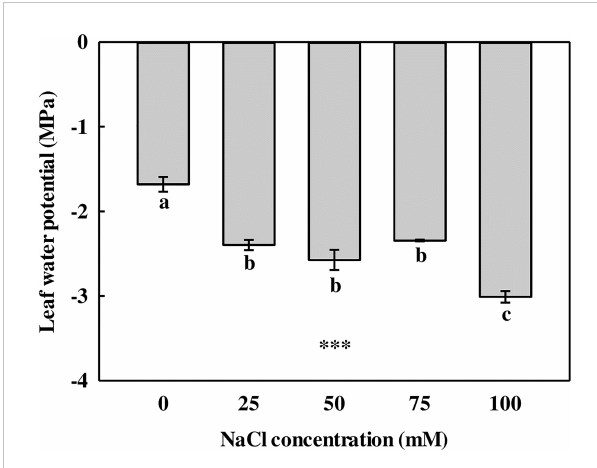
FIGURE 2 The leaf water potential of Limonium tetragonum under different NaCl concentrations ( n = 4). Statistical analysis was performed with Duncan ’ s multiple range test. *** p =